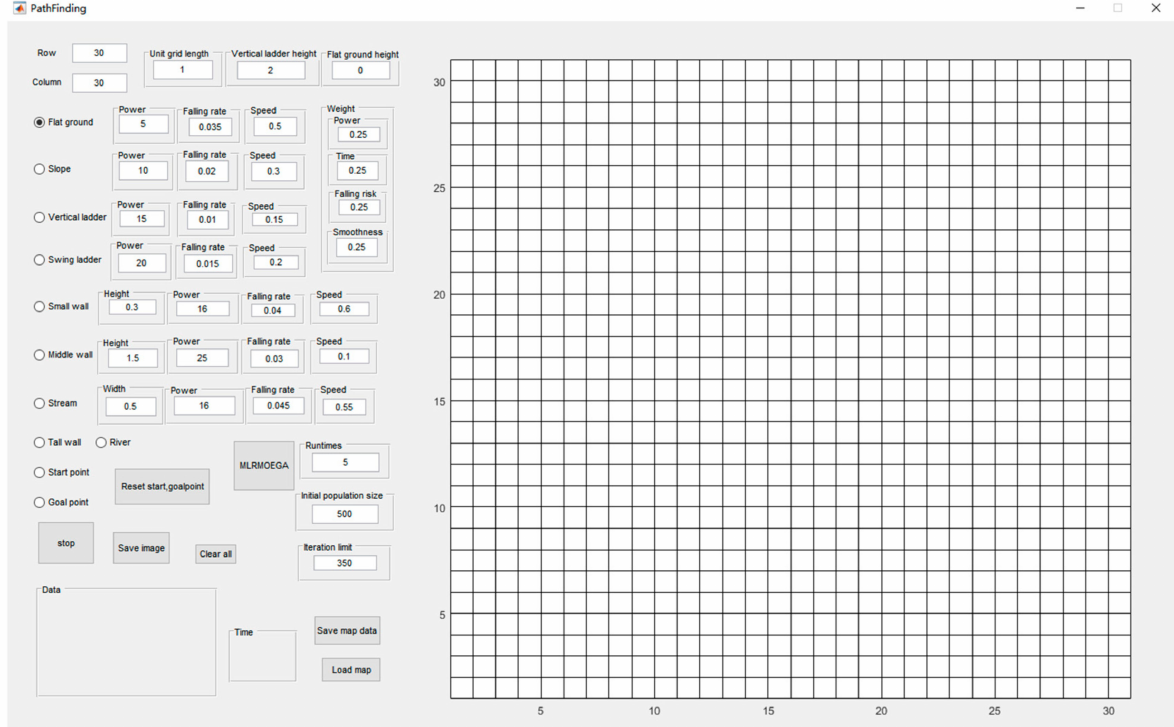
Figure 11. User interface (with 30 × 30 grid